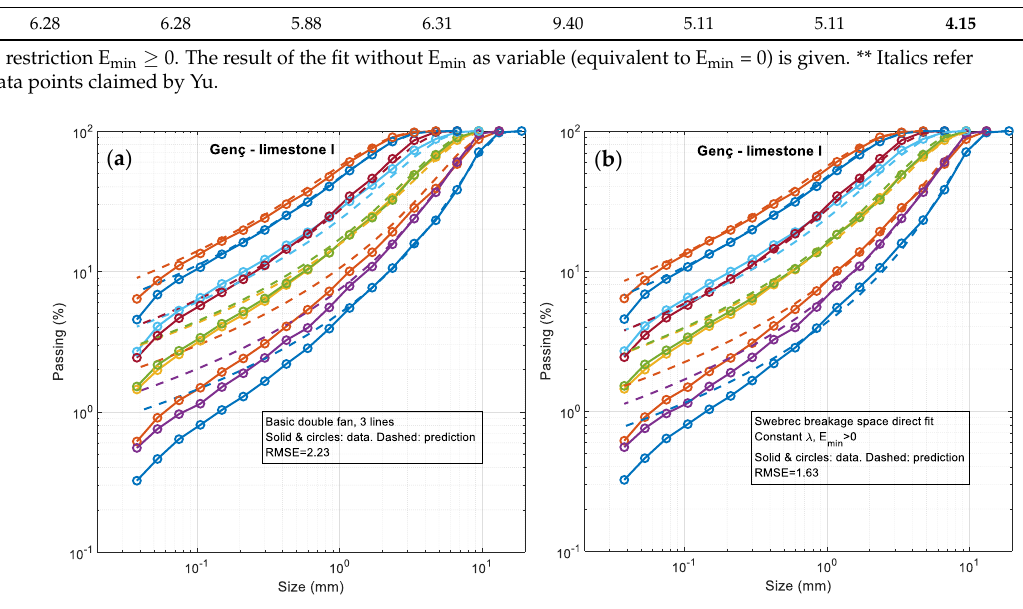
Figure 15. 3D breakage plots for Genç’s et al. [24] limestone I. ( a ) from data. ( b ) from double fan model (direct fit, constant 𝜆 , 𝐸 𝑚𝑖𝑛 ≥ 0 ). 5. Conclusions The fragmentation-energy fan models a regularity that takes place in comminution or fragmentation processes, and it literally (i) puts into equations with meaningful param- eters the (otherwise obvious) fact that the higher the energy input the smaller the size of a progeny, and (ii) the experimental observation that the log-log representation of percen- tile passing fragment sizes vs. energy converges on nearly straight lines for a wide range of specific energies. This fan model is formulated in dimensionless magnitudes, all its pa- rameters are physically sound and most have a direct graphic meaning in the fan repre- sentation: sizes, specific energies and power-law exponents (or fan line slopes). The fan model predicts with good accuracy how much a higher impact energy in DWT results in a smaller percentile fragment size, or how the particle size affects breakage. The application is simple in principle, and one should be able to obtain very close to a good BIE without advanced mathematical methods by taking the steps described in the bullet list below. For a set of sieving curves, a single fan model could be built with a com- bined graphical and simple analytical procedure as follows: •